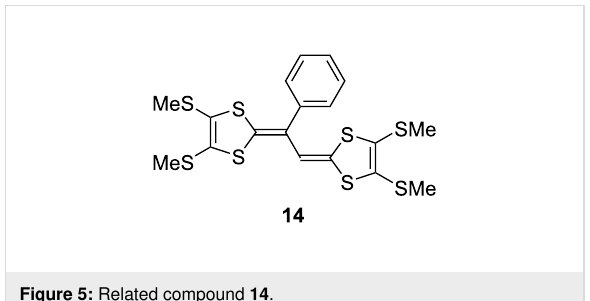
Figure 5: Related compound 14